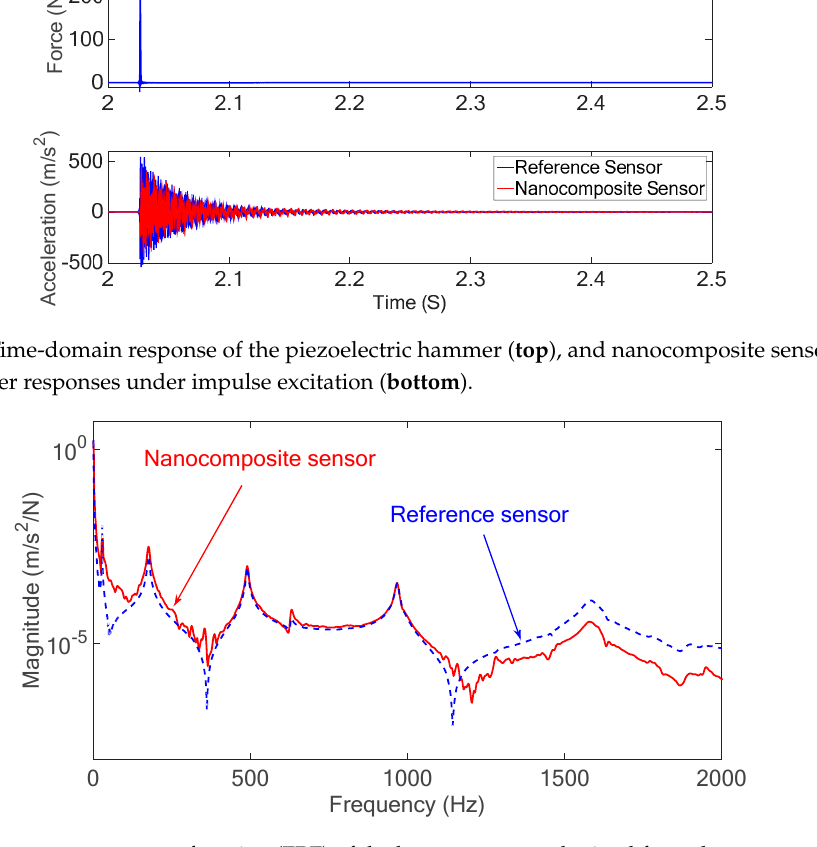
Figure 16. Frequency response function (FRF) of the beam structure obtained from the nanocomposite sensor measurements and Kistler accelerometer.